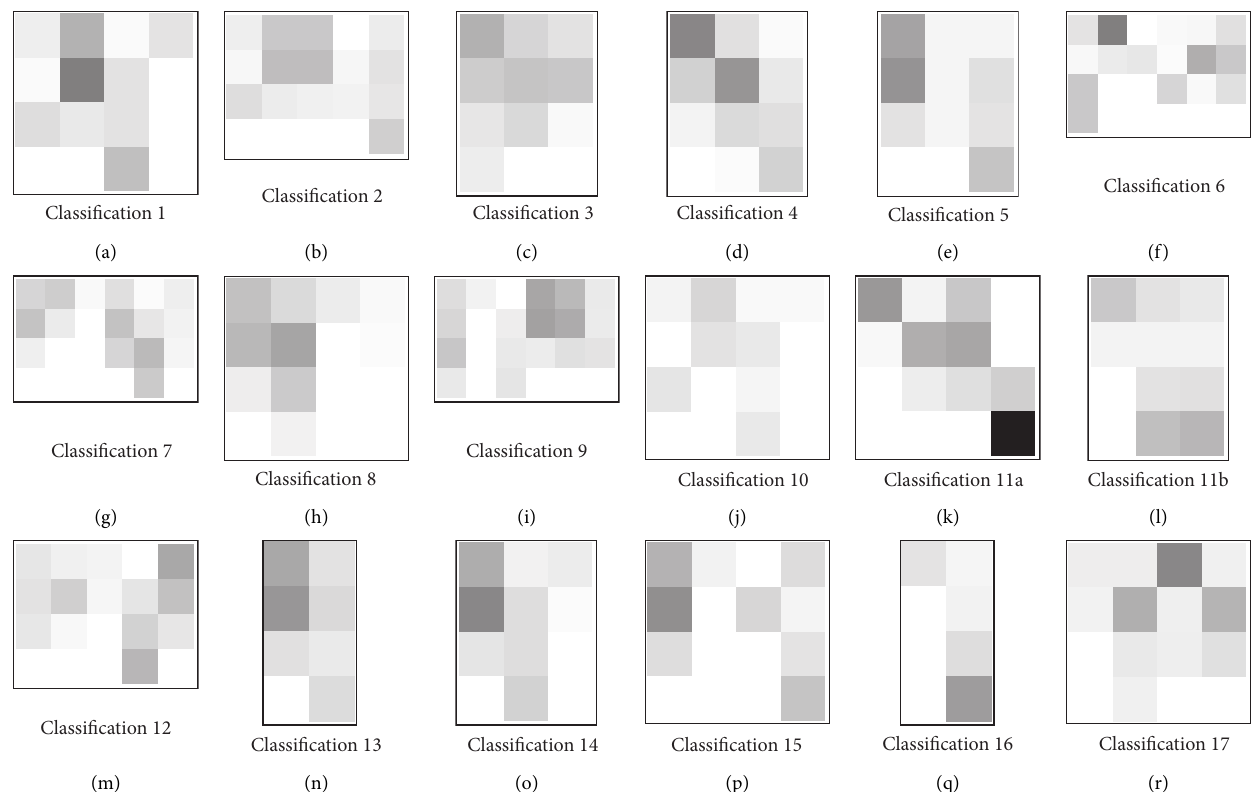
Figure 10: Comparison to known classifications of ECA rules. For each classification, we compare each of our four classes (rows A–D downward) with each of the classes in Martinez [10], by taking the ratio of the number of rules in intersection of the classes to the number of rules in the union of the classes. This gives a number between 0 and 1 which is represented by gray scale here where black is equal to one. A ratio of one indicates that two classes contain exactly the same rules and thus the other classification identifies exactly the same set of rules as a single class. A value of zero means that no rule is in both classes. Note that rules 11, 12, and 16 contain classes that coincide with our class of exceptional rules.